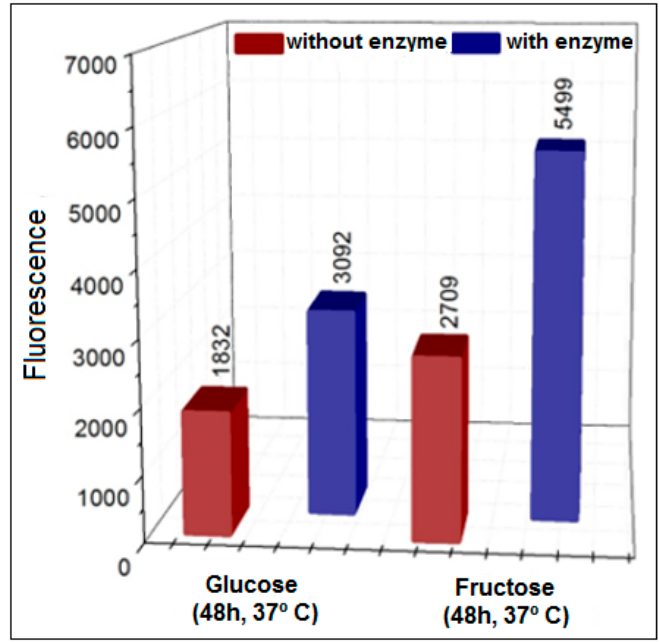
Figure 3. Formation of AGEs using glucose and fructose in the presence or absence of XO in pure phosphate buffer (pH = 6.6) with 48 h incubation at 37 °C.